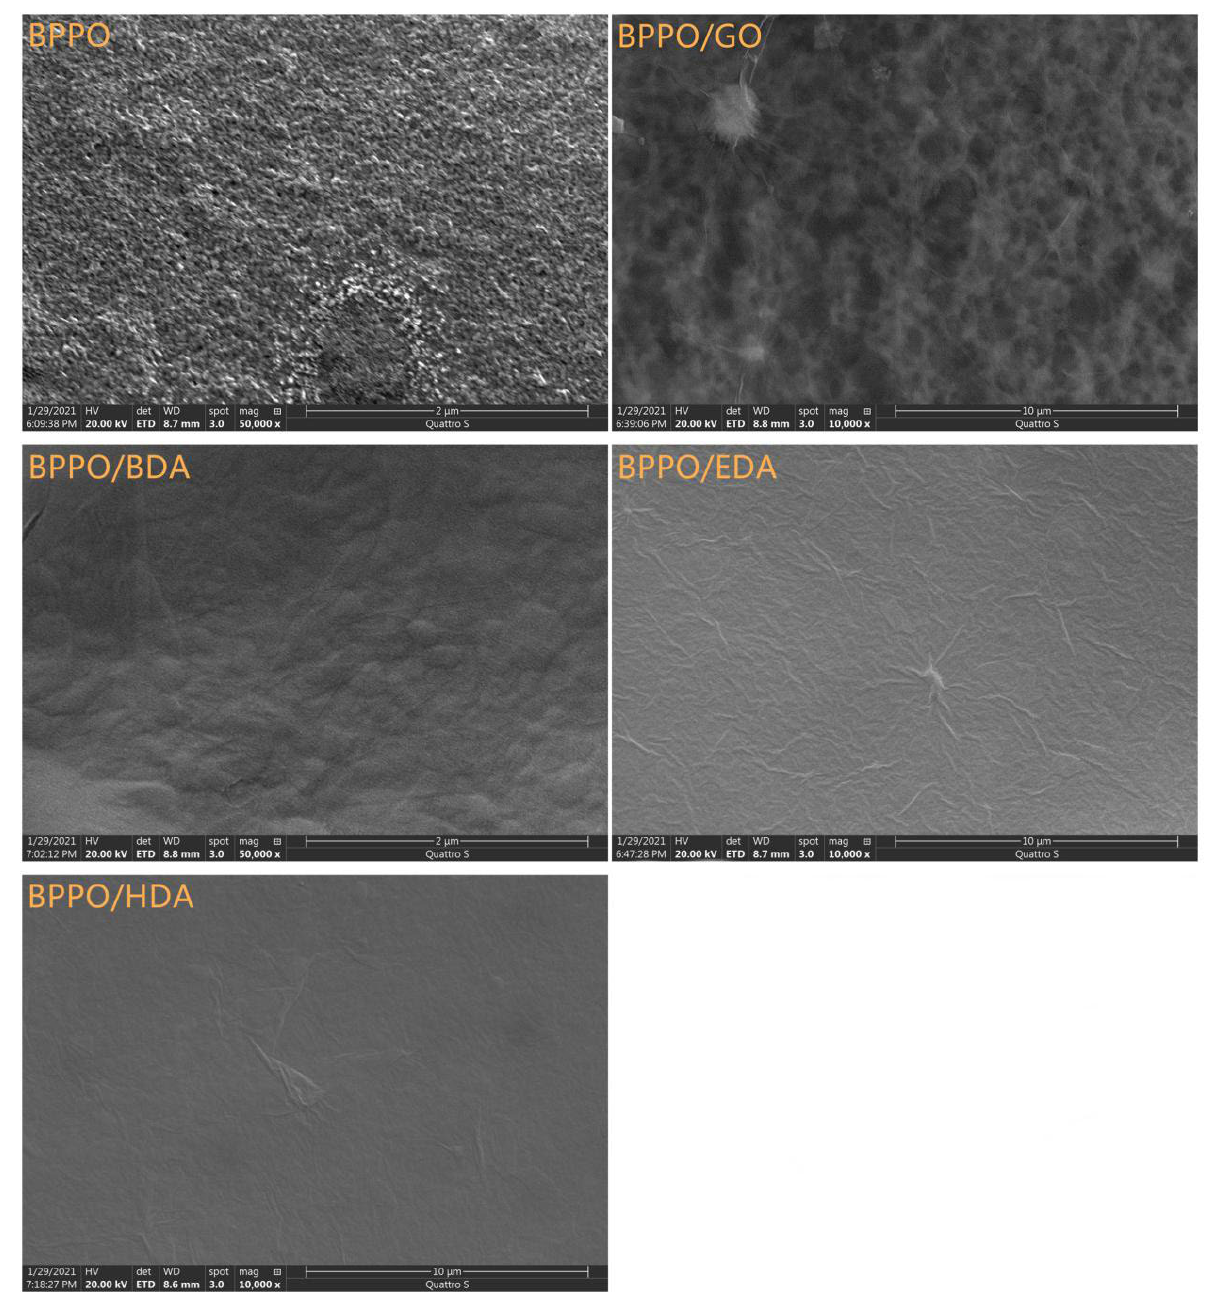
Figure 1. SEM images of the BPPO membrane, the BPPO/GO membrane, and the Ax-GO-modified nanofiltration membranes.